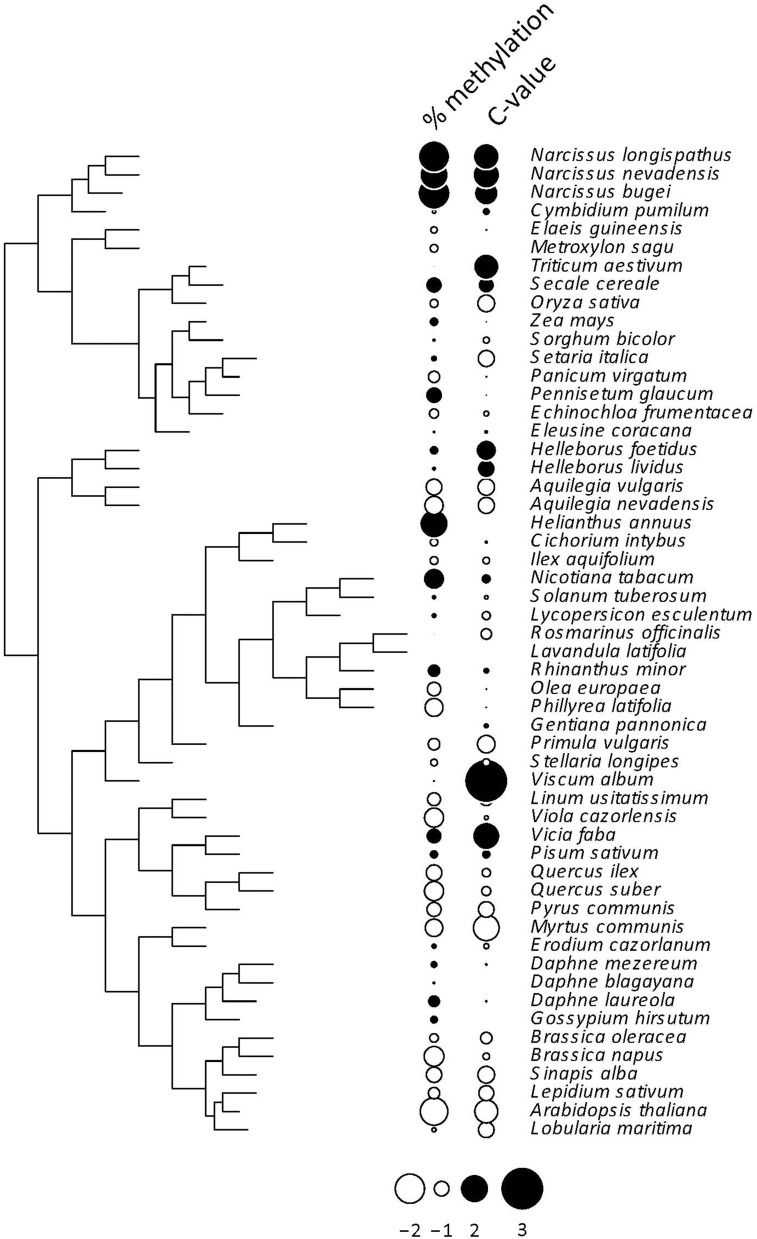
Phylogenetic tree depicting the inferred evolutionary relationships between the 54 angiosperm species considered in this study. Information on percent cytosine methylation and C-value for each species is coded as dots beside species names. The two variables were centered and scaled for the plot. See Tables S1, S2 for raw data, and Figure S1 for the distribution over the phylogenetic tree of the 12 species with missing C-value data.